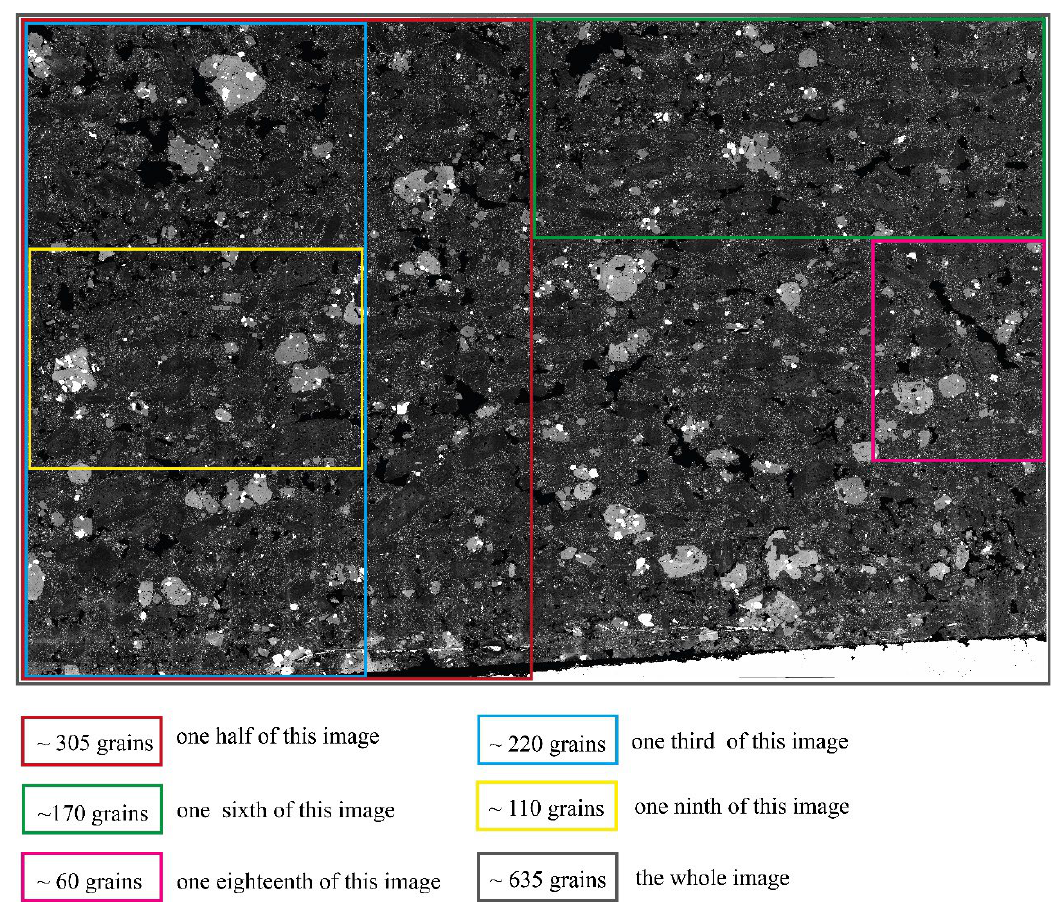
Figure 11. Five kinds of equidimensional cuts of the BSE microphotograph of rock thin section with different numbers of plagioclase mineral grains.